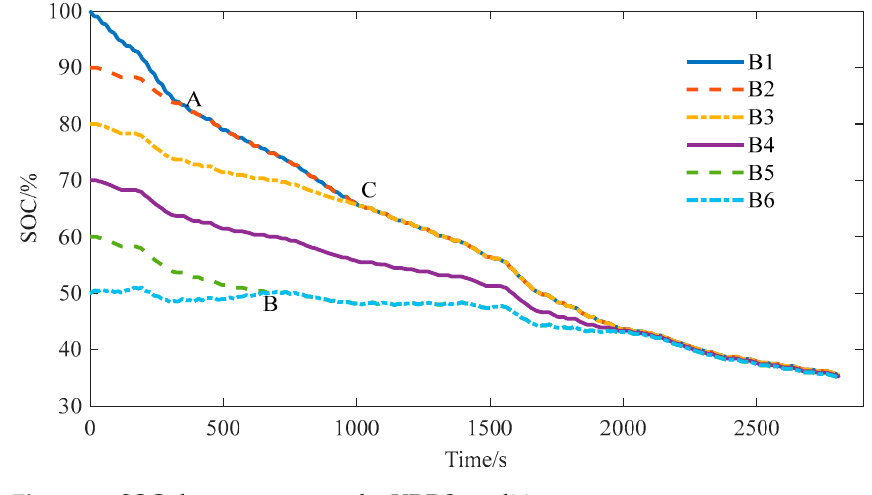
Figure 20. SOC change process under UDDS condition .